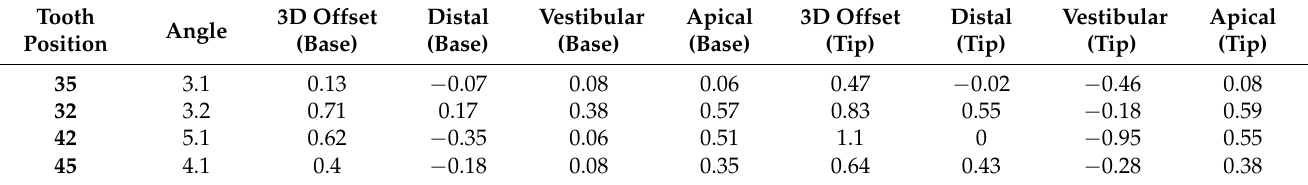
Table 3. Accuracy analysis with STL file of the printed and scanned mandible with implants and scan body inserted.